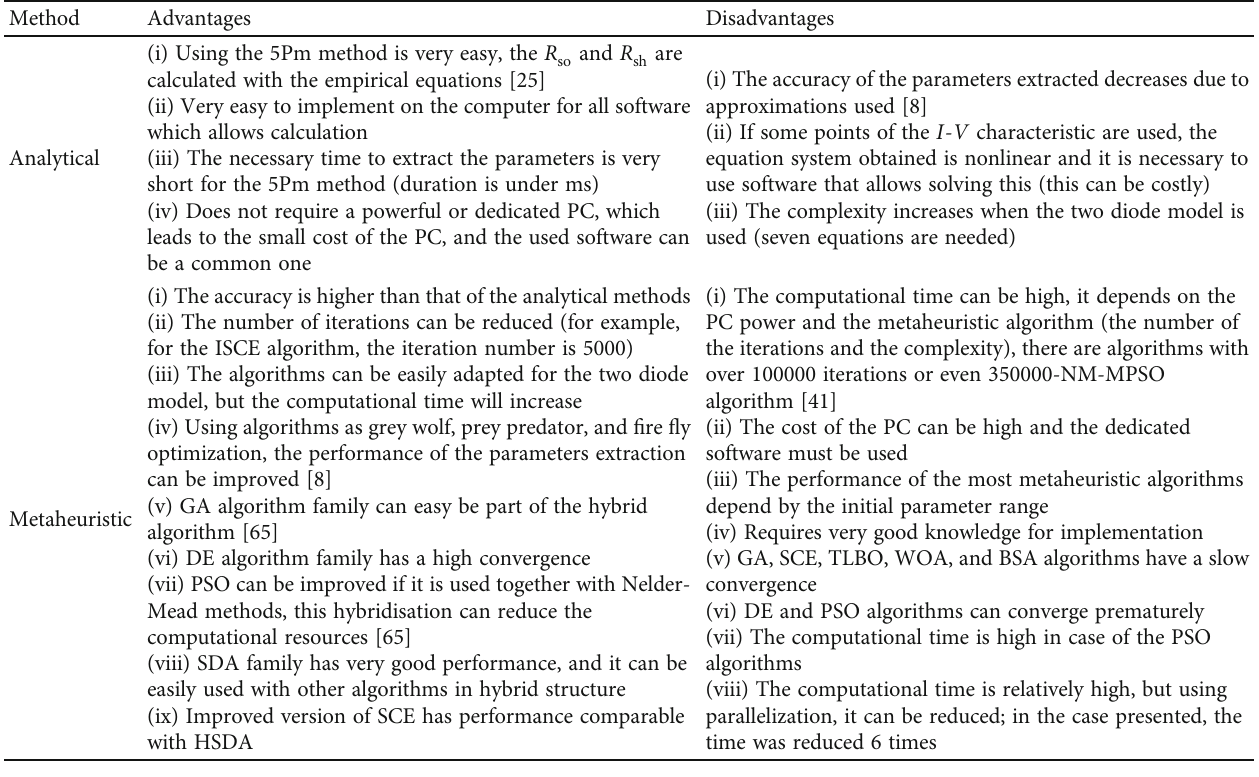
Table 10: Advantages and